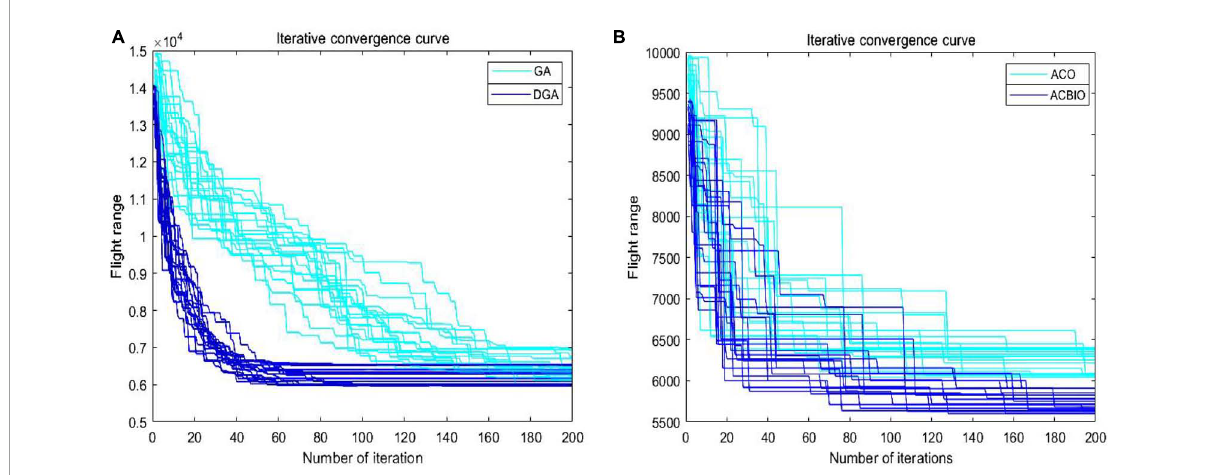
FIGURE7 Iterative convergence curves of DGA and GA (A) iterative convergence curves of DGA and GA; (B) iterative convergence curves of ACBIO and